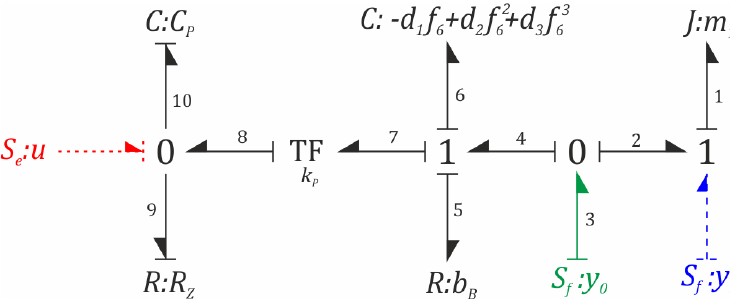
Figure 4. Bond graph of the analyzed energy harvesting system.